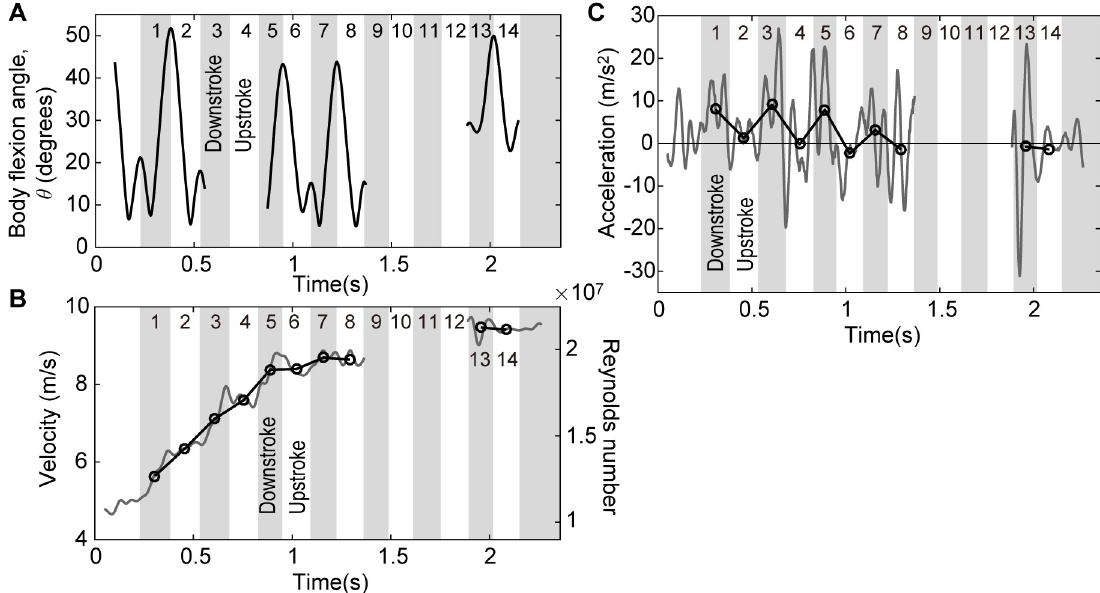
Fig 7. Time histories of the measured motion parameters. (A) The bending angle, θ . (B) Velocity and Reynolds number. (C) Acceleration. Open circles indicate stroke-averaged values. Strokes are numbered from 1 to 14. The fluke marker was out of sight during the 3rd, 4th, and 9-12th strokes. Velocity and acceleration data between the 9th stroke and the 12th strokes were excluded from the following analysis since the lateral markers were out of sight. See also S3 and S4 Datasets for the timings of key events and the time-series data of the velocity and acceleration,